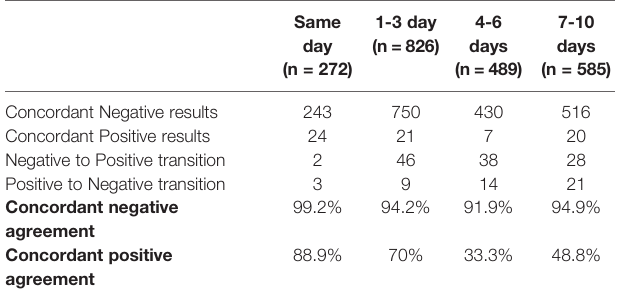
TABLE 1 | Agreement between URT samples collected in a repeatedly in patients over a short